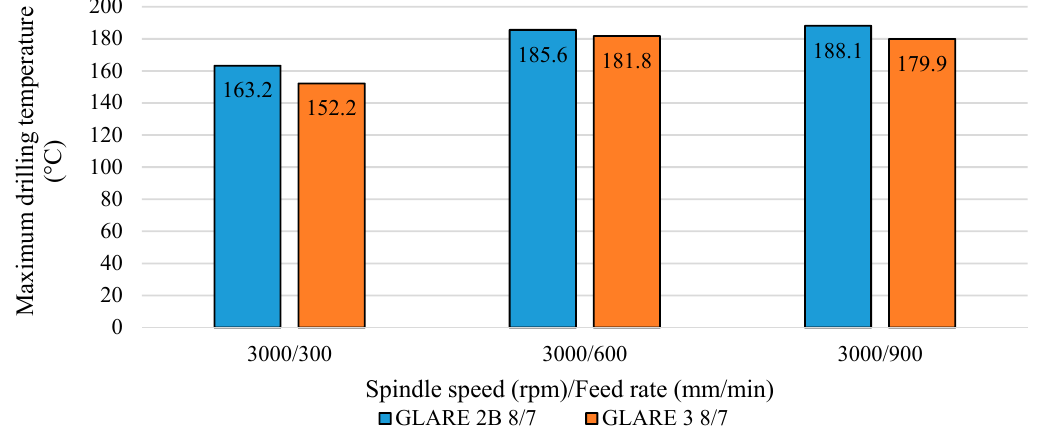
Figure 7. Maximum drilling temperature and the influence of fiber orientation in GLARE.